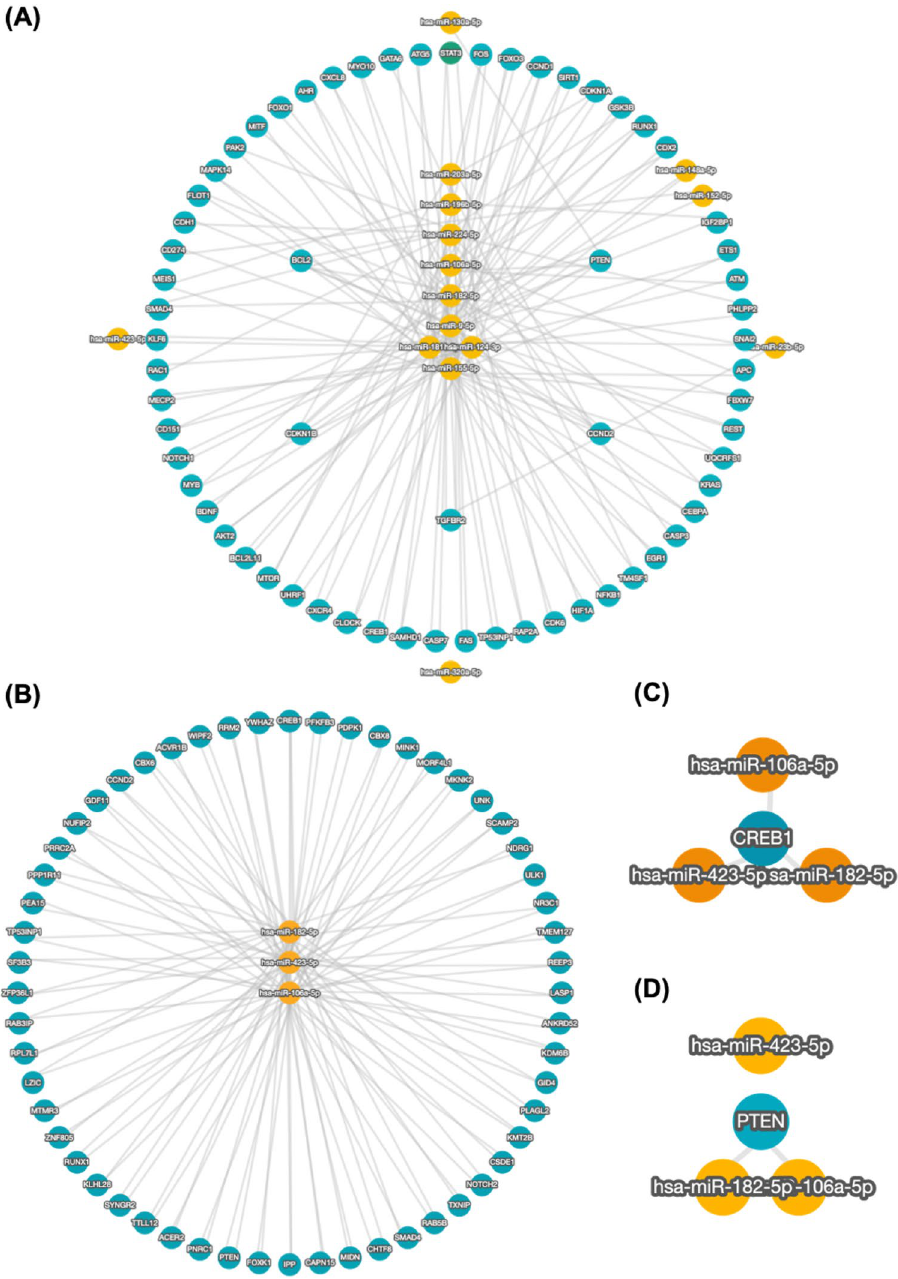
their target gene network. MiRNAs targets used were only the validated miRNAs whether with strong or weak validity with additional filter of minimum 2 shared targets. ( C ) The top three miRNAs according to ROC analysis with filtering options choosing strong validated targets only with minimum shared two targets revealing CREB1 gene as a common shared target ( D ) The top three miRNAs according to ROC analysis with filtering options choosing strong validated targets only with minimum shared three targets revealing PTEN gene as a common shared target for miR-182 and miR-106a but not with miR-432 using miRTargetLink 2.0 (https:// ccb- compu te. cs. uni- saarl and. de/ mirta rgetl